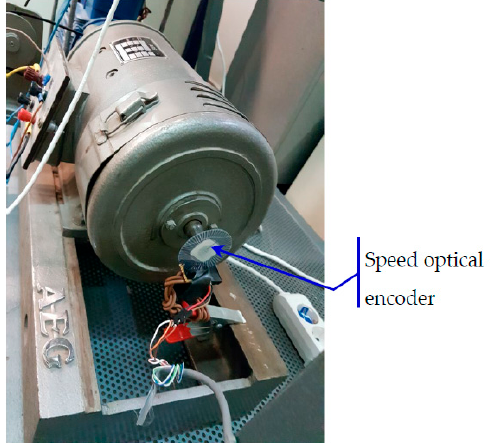
Figure 5. Experimental system (details): ( a ) monitor, keyboard, inverter, adapter USB-RS485, volt- meter, ammeter, power supply network, central control panel; and ( b ) IM Control Interface.